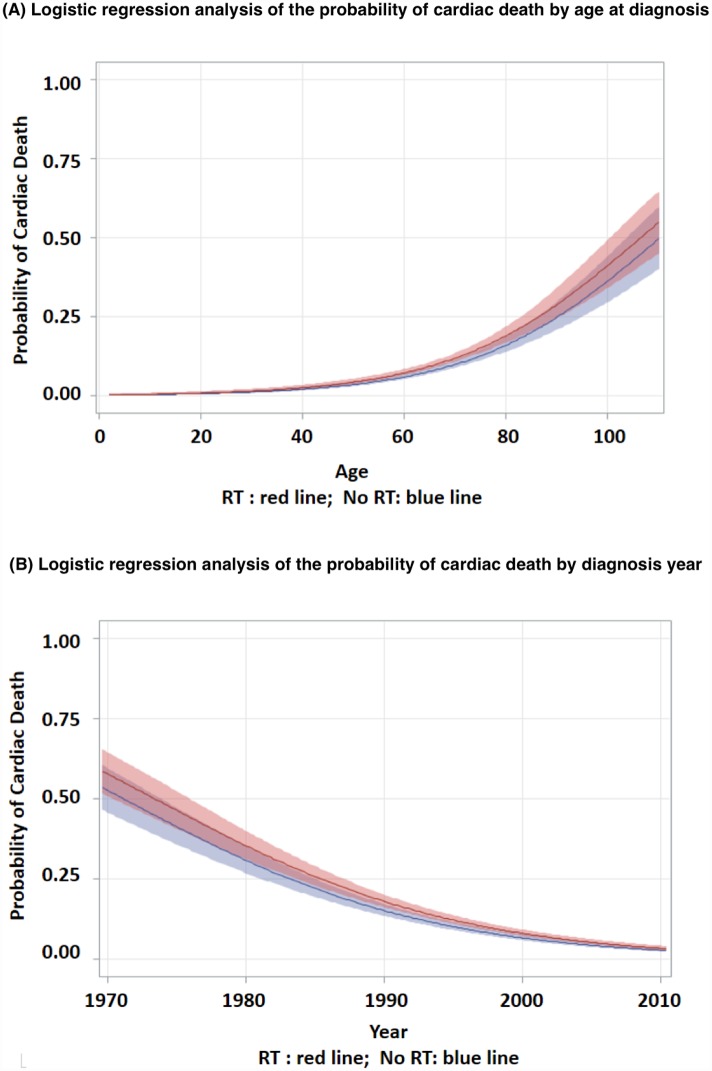
Logistic regression analysis of the probability of cardiac death by (A) age at diagnosis and (B) diagnosis year (shading represents 95% confidence interval).